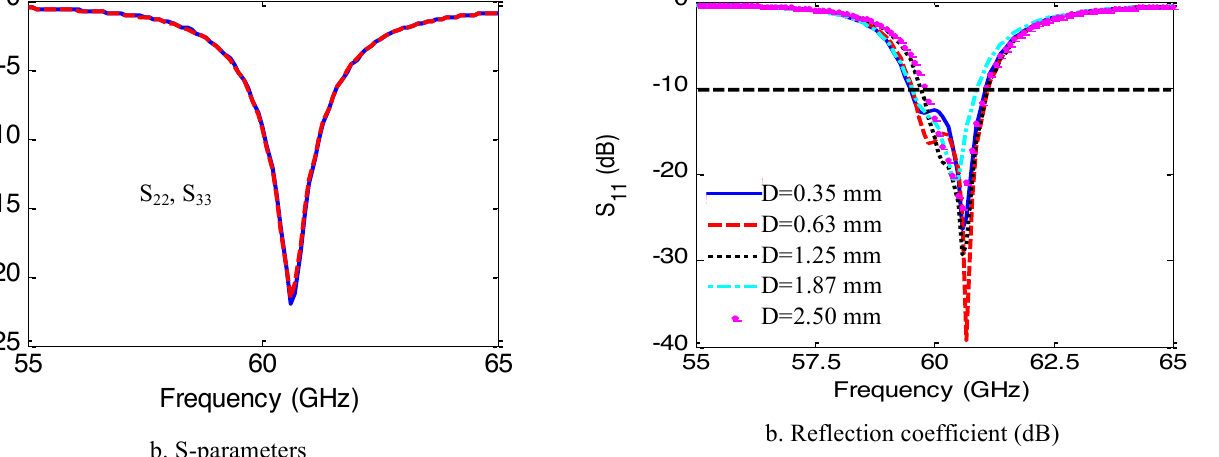
Fig.9 a. The geometry of the dual-polarized microstrip on- chip patch antenna with six-metal layers. b. The variation of the S-parameters versus frequency for the dual-polarized microstrip patch on-chip antenna in the presence of the six- metal layers.